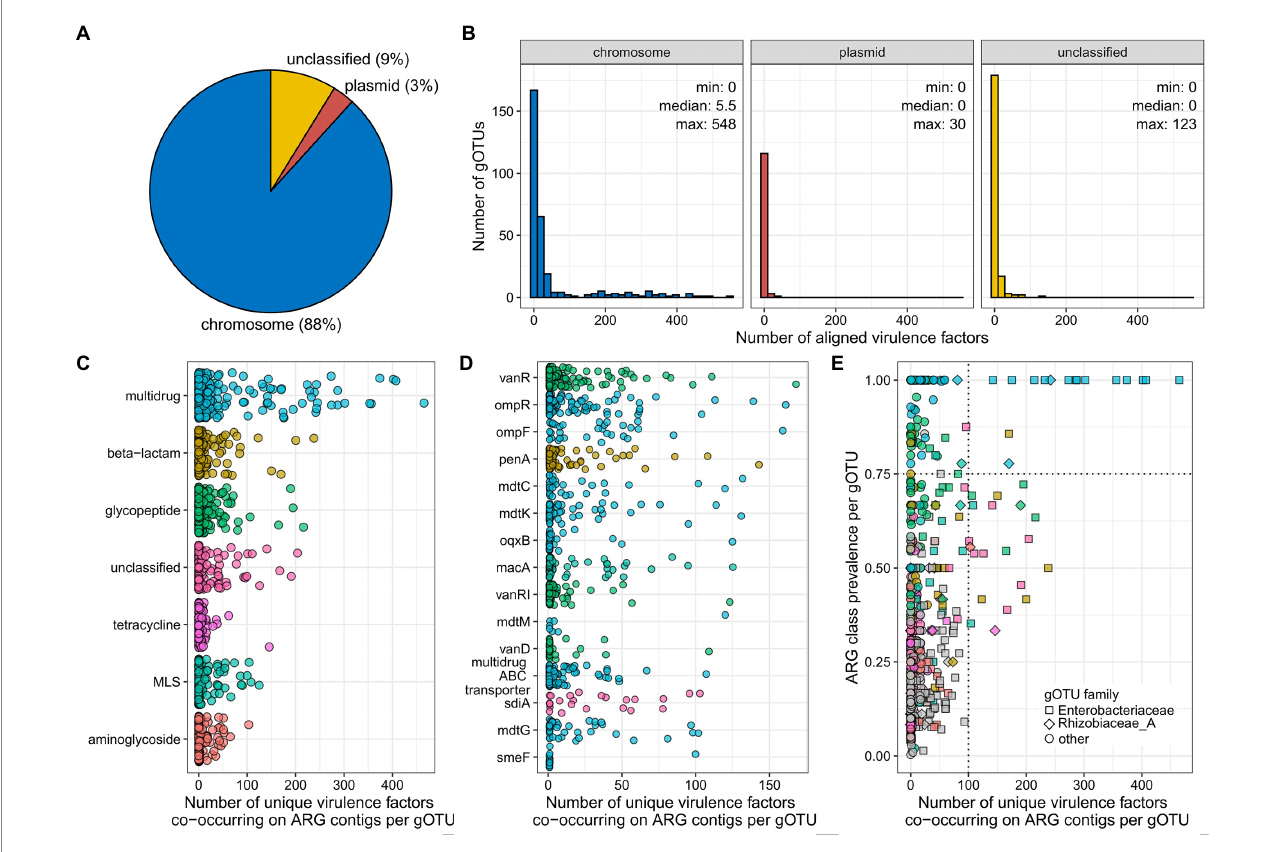
FIGURE 3 Occurrence of ARGs on plasmids and co-occurrence with virulence factors. (A) Percentages of ARGs found on chromosomes, plasmids, or unclassified reads in our data, as determined by PlasFlow (Krawczyk et al., 2018). (B) Histograms showing the number of aligned virulence factors (Sayers et al., 2019) per gOTU per read type (chromosome, plasmid, unclassified). (C) Number of unique virulence factors that co-occur on contigs with ARGs belonging to each ARG class, per gOTU. Show are only those ARG classes that had more than 100 co-occurring virulence factors in at least one gOTU. (D) Number of unique virulence factors that co-occur on contigs with ARGs belonging to the multidrug ARG class, per gOTU. Show are only those ARGs that had more than 100 co-occurring virulence factors in at least one gOTU. (E) ARG class prevalence per gOTU as a function of the number of unique virulence factors that co-occur on contigs with ARGs belonging to each ARG class, per gOTU. Highlighted are gOTUs that have both ubiquitous ARG classes and contain more than 100 co-occurring virulence factors for ARGs in the ARG class. The colors correspond to the ARG classes and the shapes to the gOTU taxonomic family. Shown are only those gOTUs that contained more than five